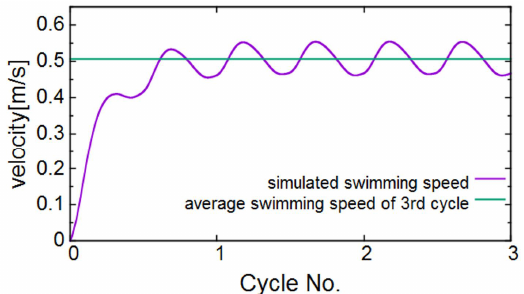
Figure 9. Result of swimming velocity in the simulation. The average swimming speed of the third cycle was 0.51 m/s. The peak-to-peak fluctuation during the third cycle was 0.091 m/s (17.8% of the average swimming